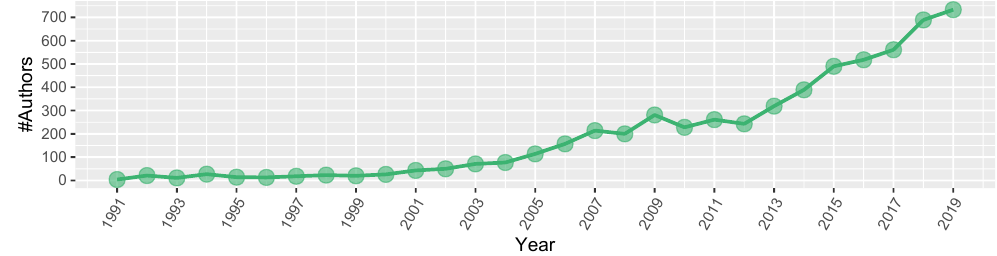
Figure 6. Number of authors per